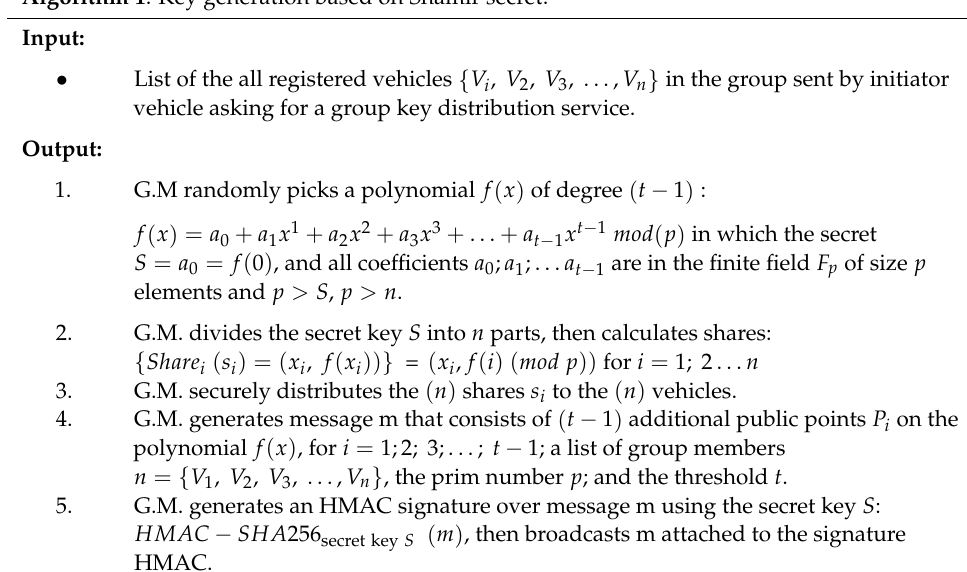
Figure 3. The proposed key generation and distribution process. Algorithm 1 . Key generation based on Shamir secret